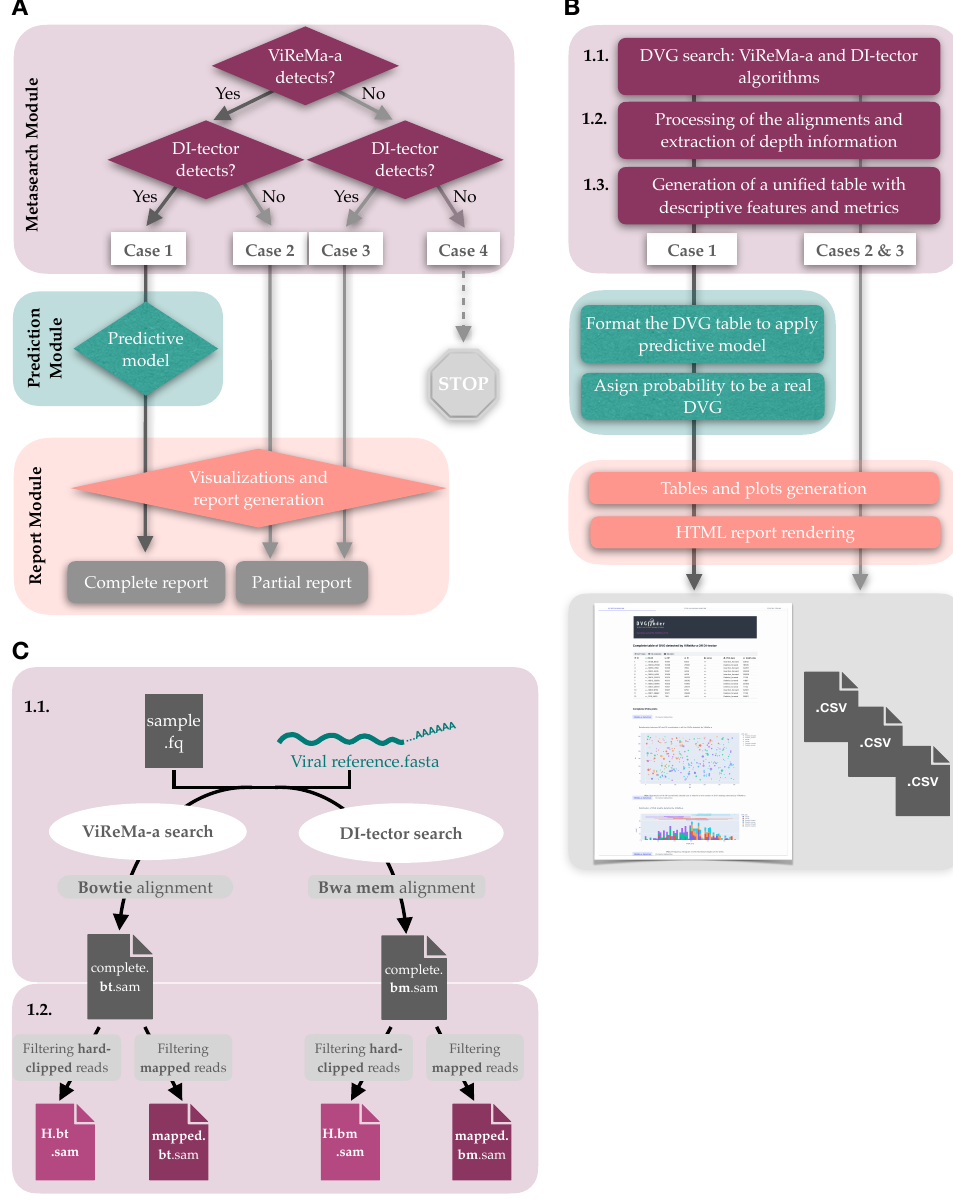
Figure 2. DVGfinder flow chart. ( A ) General workflow of the program with the four cases of usage accounted. ( B ) A more of detailed description. ( C ) Simplification of the two first steps of the Metasearch module, with emphasis on the processing of the different alignments